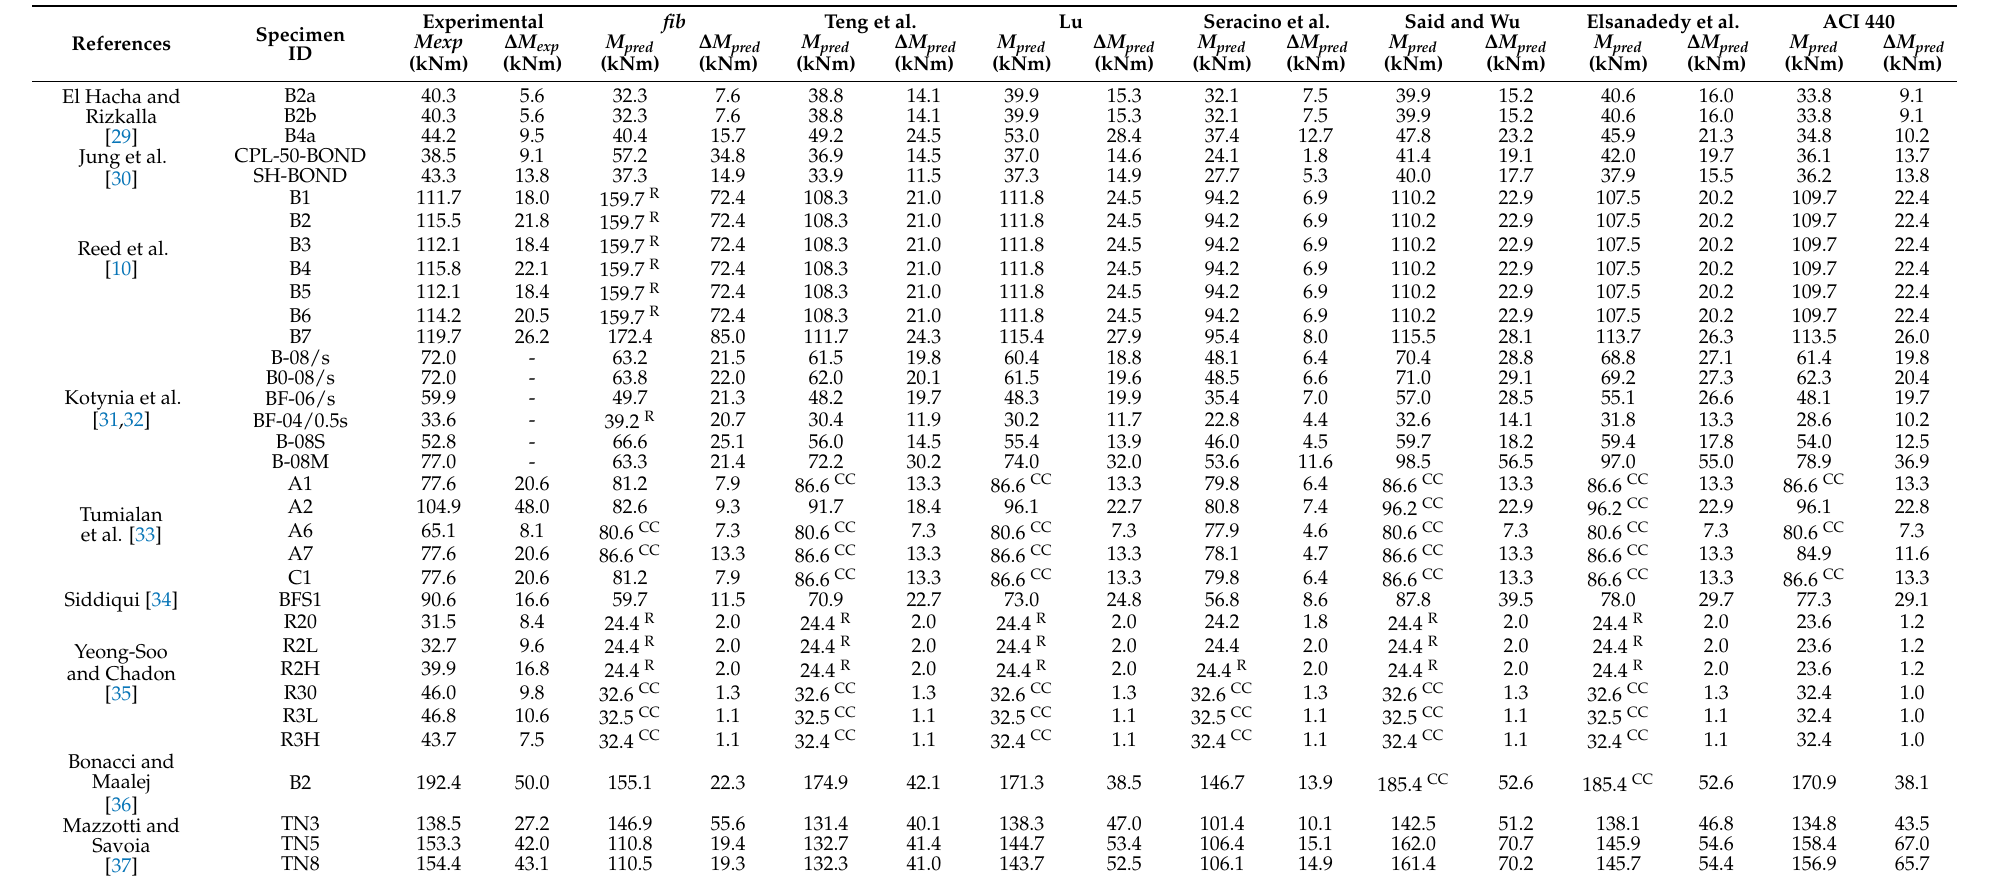
Table 2. Parameters of specimens selected for